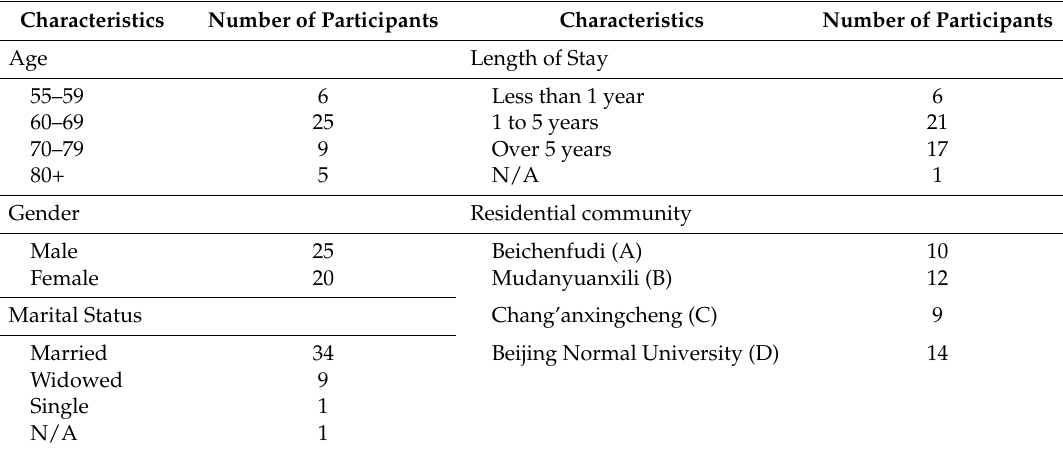
Figure 2. The location of the case study sites. Table 1. The information on the